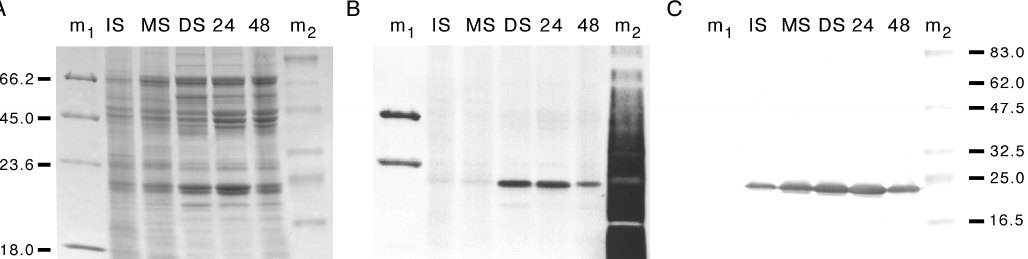
Figure 2. Developmental changes in the abundance of P. vulgaris seed membrane proteins showing that PvTIP3 proteins are the primary phosphoproteins. ( A ) Coomassie and ( B ) phosphoprotein stained gels. ( C ) Immunoblot using antisera to PvTIP3 proteins. Gel lanes: IS, immature seed; MS, mature seed; DS, dry seed; 24, seed imbibed for 24 h; 48, seed imbibed for 48 h. Lane m1, Peppermint Stick phosphoprotein markers; lane m2, broad-range prestained molecular weight standards. Position of Peppermint Stick markers indicated at left along with the respective molecular weight in kDa. Position of broad-range prestained molecular weight standards (kDa) indicated at right. Background fluorescence in lane m2, panel B is from phenol red used by the manufacturer in the marker protein